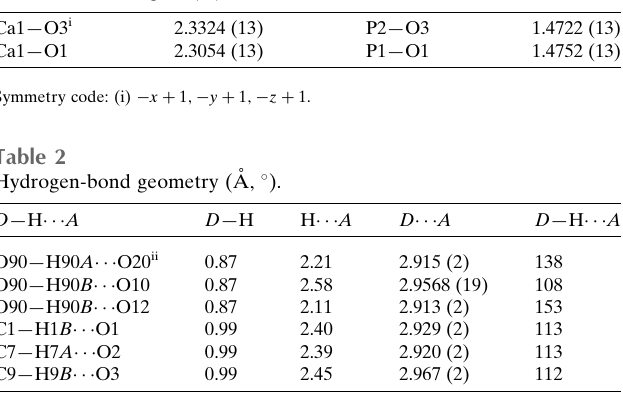
Table 1 Selected bond lengths (A˚ ).